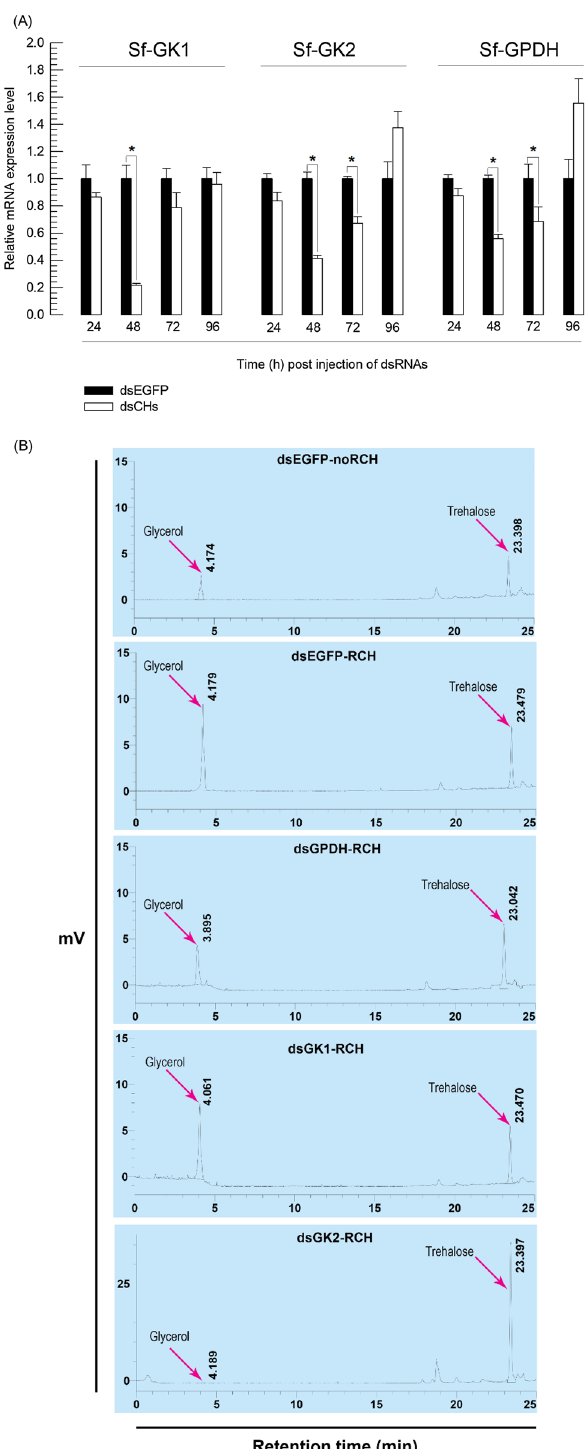
Figure 7. The effect of RNA interference (RNAi) specific to genes linked with glycerol biosynthesis, GPDH and GK of Spodoptera frugiperda . All dsRNAs specific to target glycerol biosynthesis genes were constructed at ~ 300–400 bp and injected to each L5 larva at 3 μg. Control RNAi (‘dsEGFP’) was injected with dsRNA specific to EGFP gene. ( A ) Quantitative real-time PCR to monitor changes in mRNA levels of Sf-GPDH, Sf-GK1, and Sf-GK2 after RNAi. EF1 was used to validate cDNA integrity. ( B ) Chromatogram of HPLC that shows the effect of RNAi specific to glycerol biosynthesis genes, (48 h post dsRNAs injection) and RCH treatment (5 °C for 6 h), on glycerol content in hemolymph of fifth instar larvae. ( C ) Suppression of cold tolerance after RNAi treatment of either GPDH or GK1 or GK2. The glycerol content in hemolymph of fifth instar larvae was measured after 48 h of dsRNAs injection. ( D , E ) After RNAi injection (48 h post injection) and RCH treatment (5 °C for 6 h), the larvae were incubated at − 10 °C for 1 h and the mortality was recorded. Each treatment was replicated three times with 10 individuals per replication. Asterisks indicate significant difference between RCH and no RCH treatments (Type I error = 0.05, LSD test). n.s. means no significant